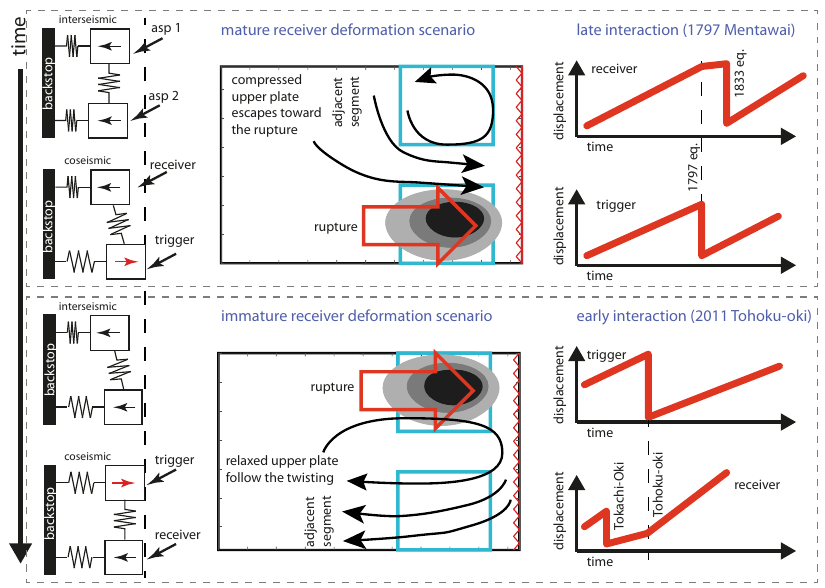
Fig. 4 Temporal evolution of seismic cycling in mature and immature interaction scenarios. Coupled spring-slider system represents alternating trigger and receiver segments of a generic subduction zone. Failure of asperity 2 with asperity 1 close to the end of the loading phase represents a “ mature ” receiver. Failure of asperity 1 with asperity 2 at the beginning of the loading phase represents an “ immature ” receiver